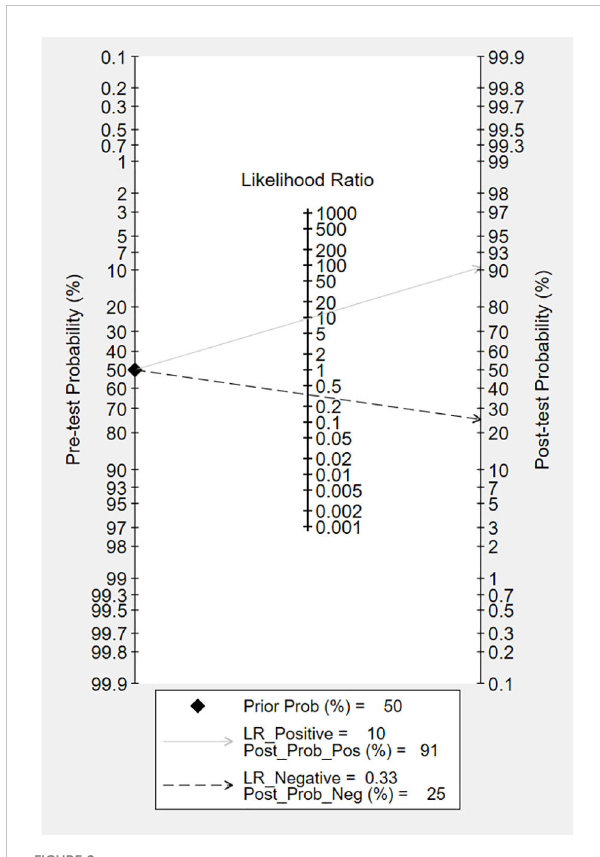
FIGURE 2 Forest plots depicting the SEN and SPE of CTCs in BC diagnosis.